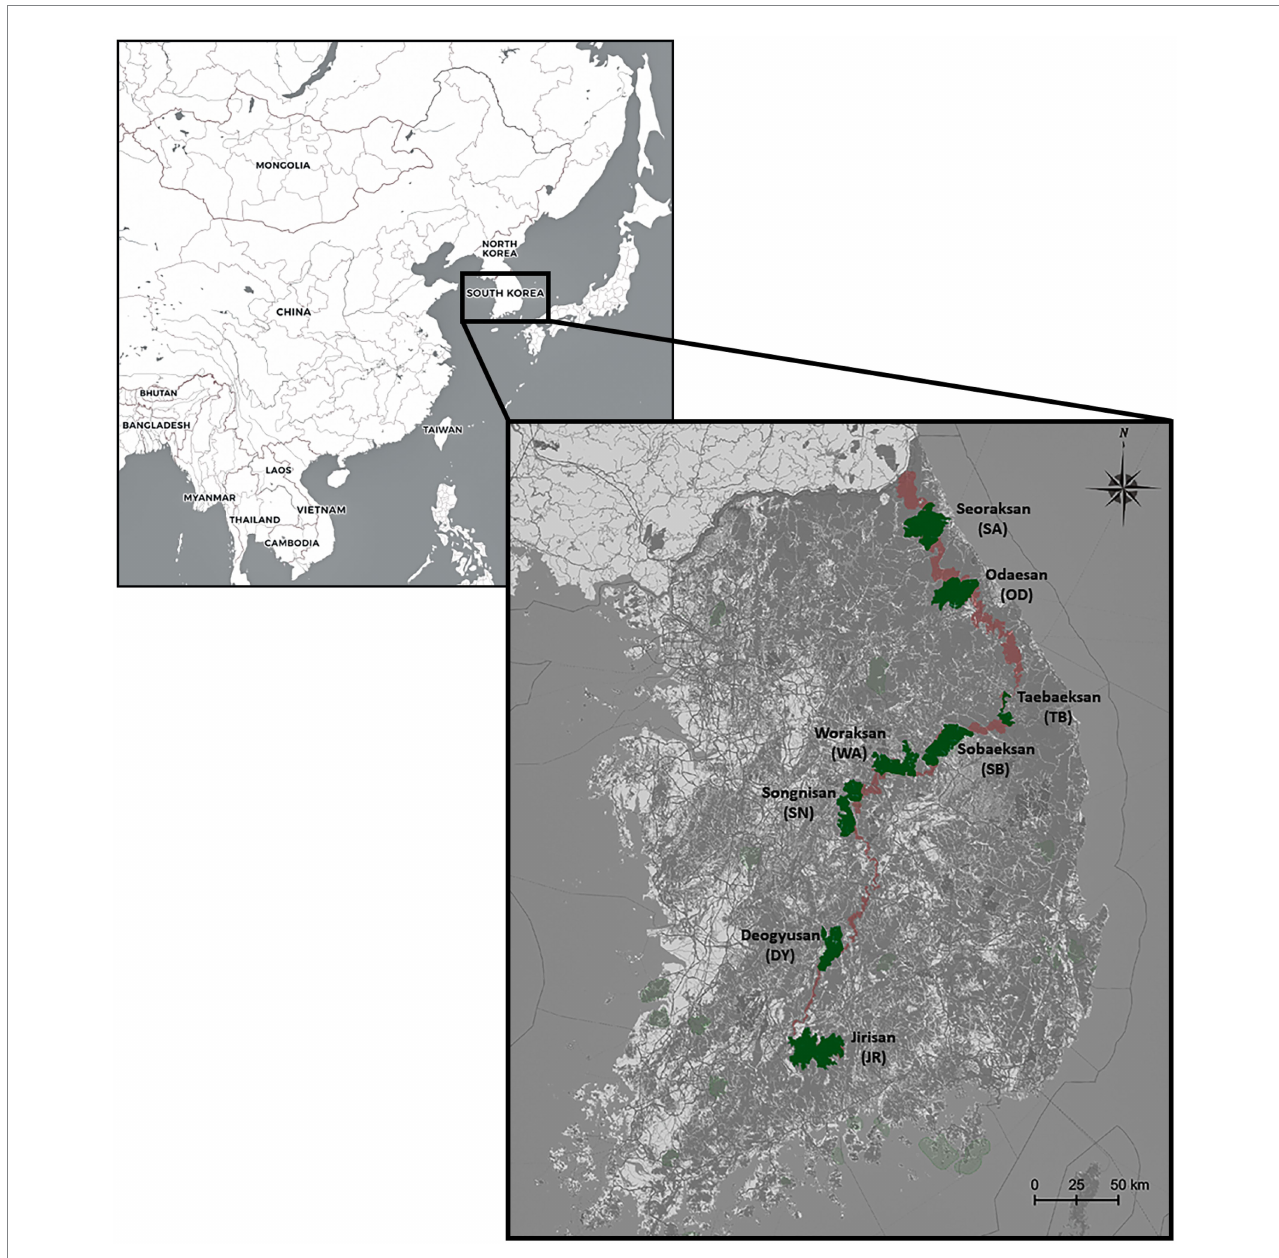
FIGURE 1 Sampling sites of the eight national park populations of Apodemus agrarius in South Korea. The range in dark red displays the Baekdudaegan Mountain Range (BMR) and areas in green denote the eight national parks examined in this study. The geographic map was generated by Quantum Geographical Information System (QGIS) software